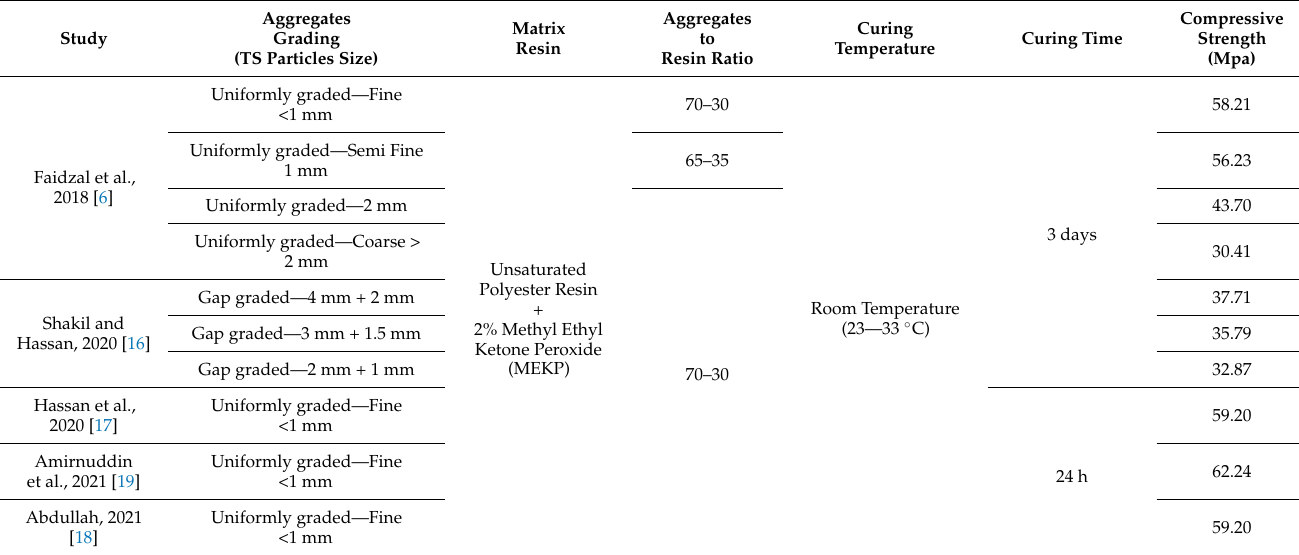
Table 1. Summary of TSPC compressive strength performance under various graded, composition, and preparation